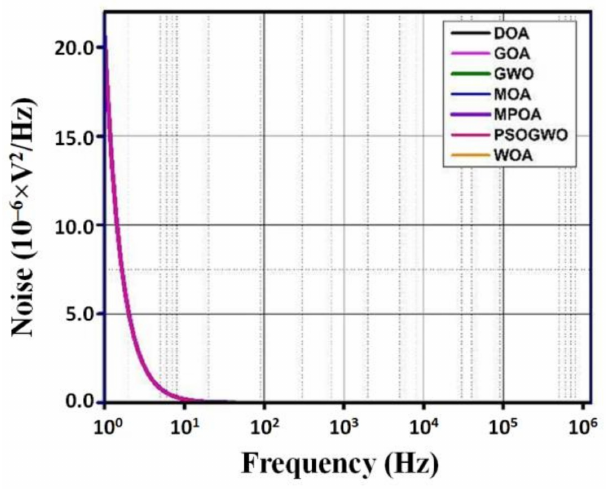
Figure 7. Phase vs. frequency plot for metaheuristic algorithms.